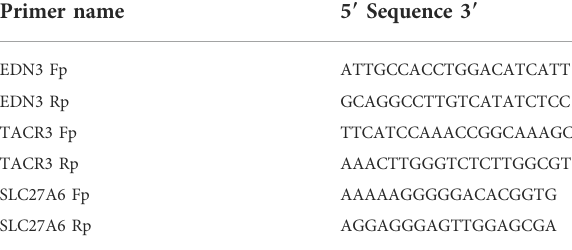
TABLE 1 All primer sequences used in